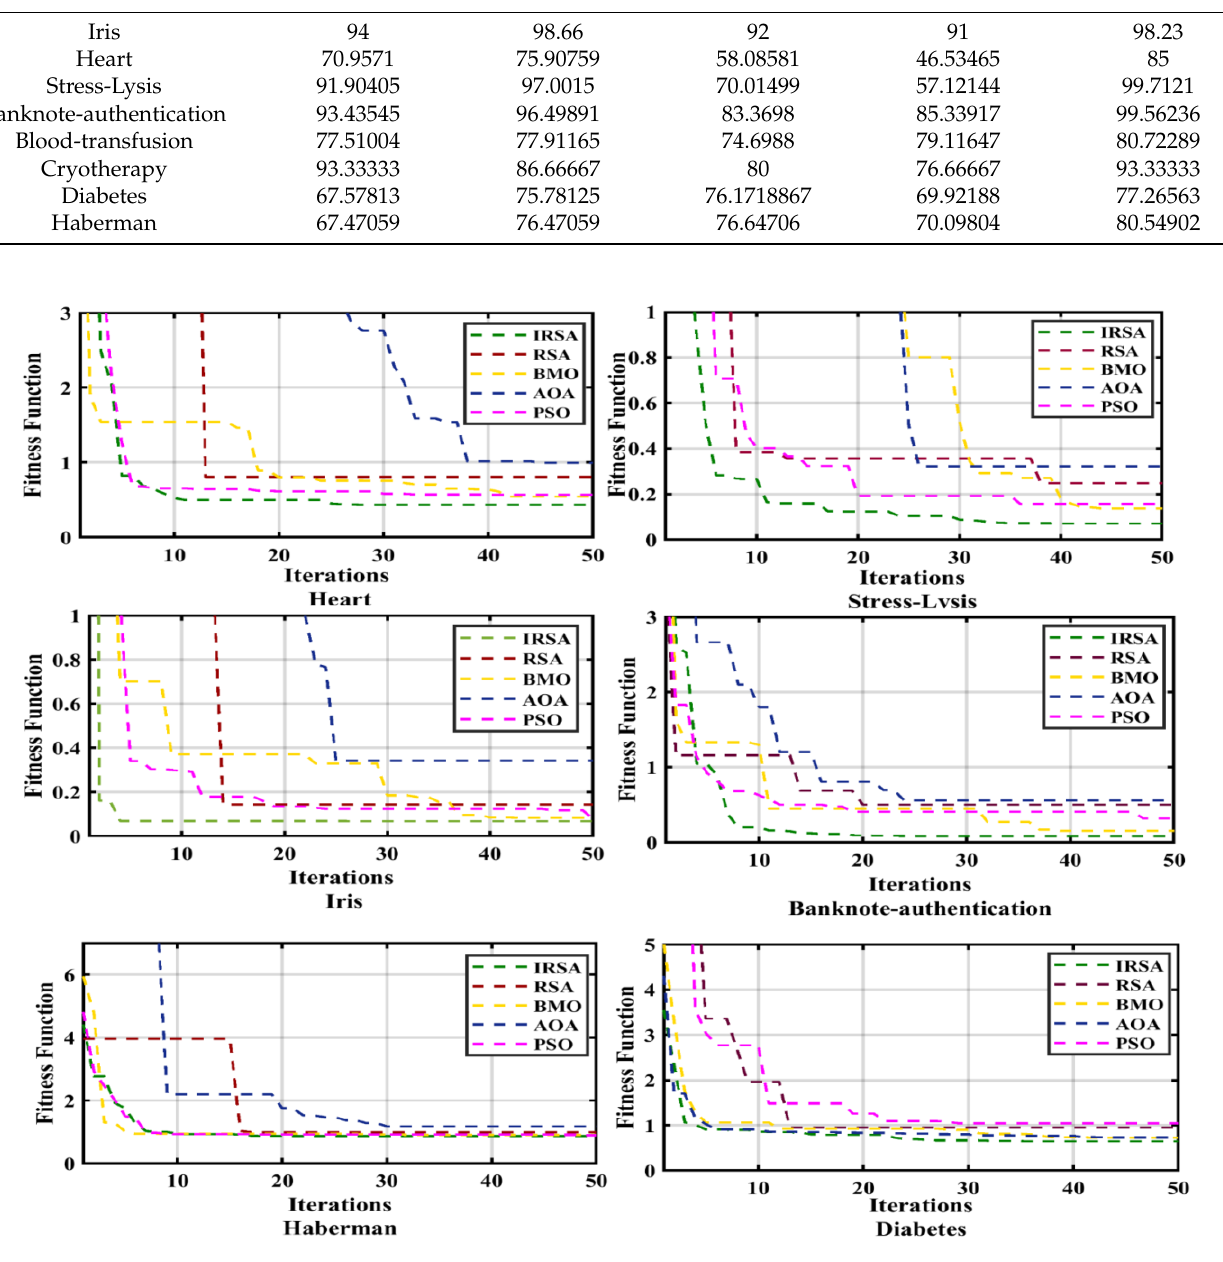
Figure 8. Convergence curves for classification.